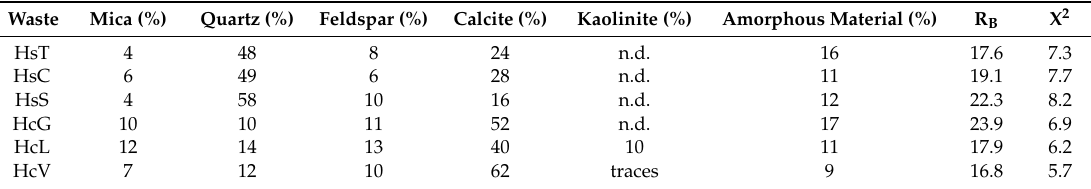
Table 2. Rietveld refinement of starting concrete